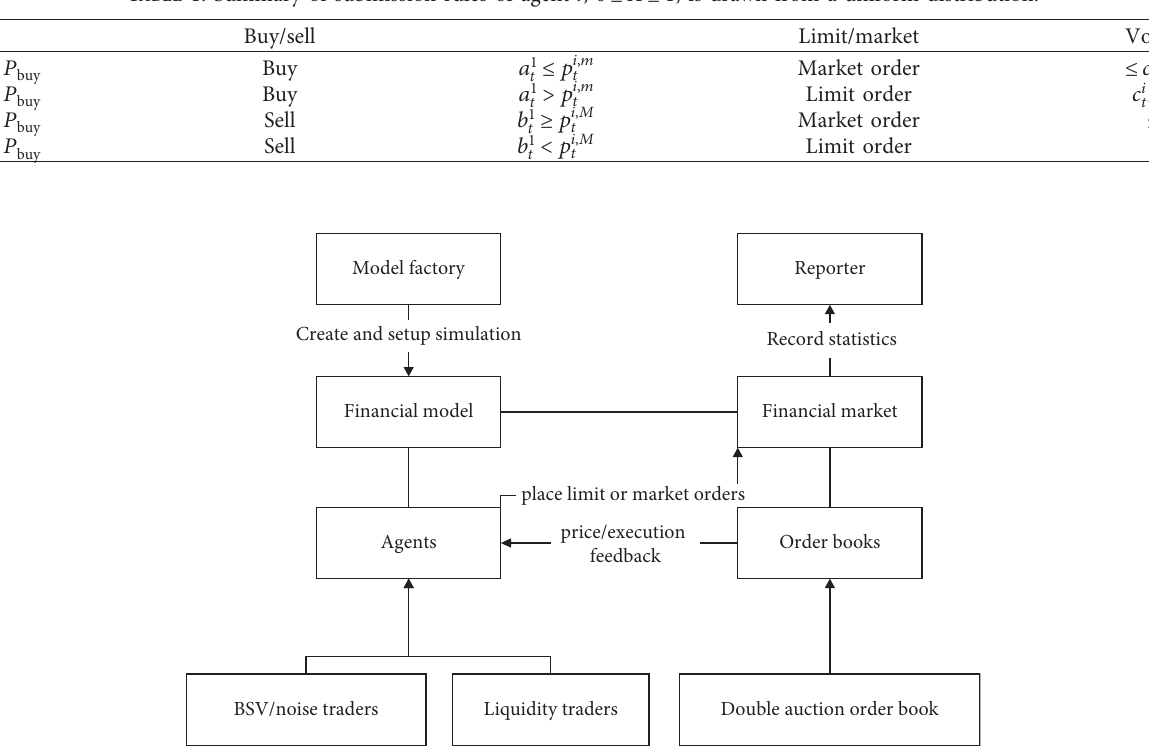
Figure 1: The architecture of artificial limit order market.